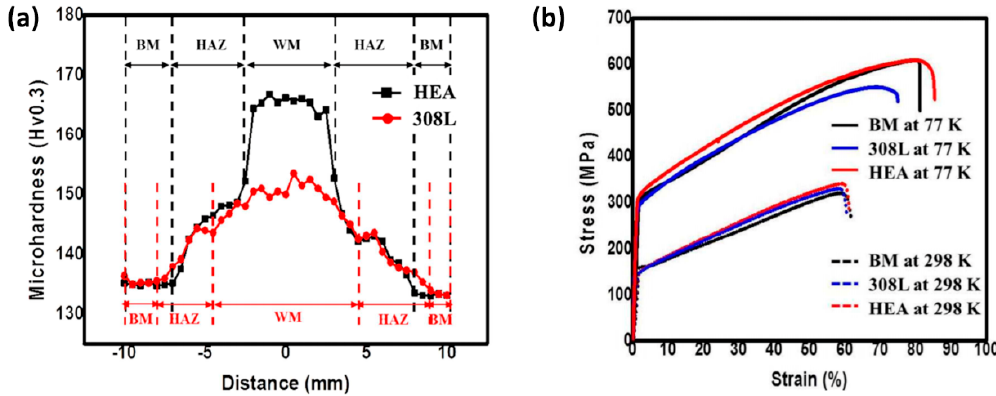
Figure 7. Mechanical behavior of the welded joints: ( a ) Tensile testing; ( b ) microhardness distribution (Adapted from [63], with permission from Elsevier, 2020).